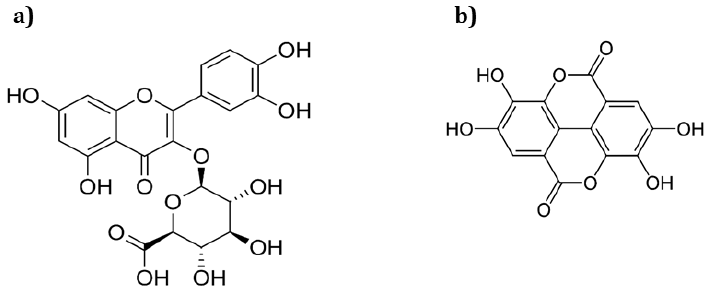
Figure 1. Chemical structure of ( a ) quercetin-3- O -glucuronide and ( b ) ellagic